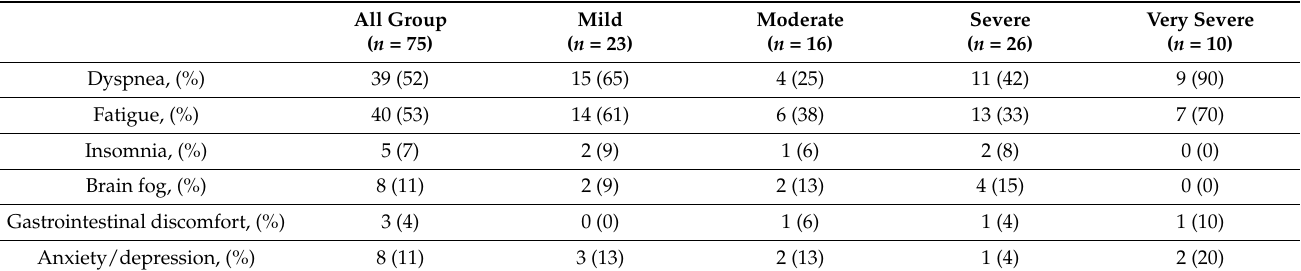
Table 5. Reported symptoms at the time of the